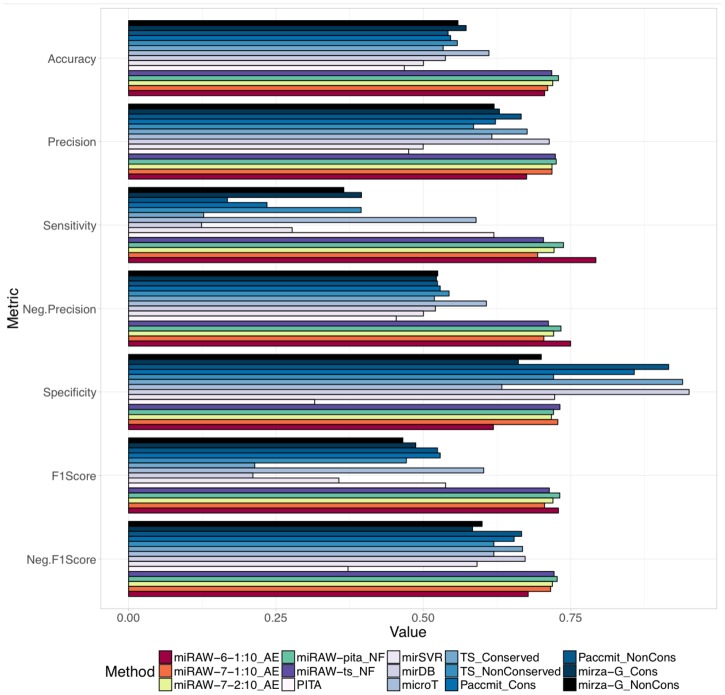
Comparison of miRAW with different CSSMs and eight other commonly used target prediction tools (TargetScan C & NC, Diana microT-CDS v4, PITA v6, miRanda, Paccmit, mirzaG and mirDB).Colouring for miRAW results are consistent with the color scheme in Fig 5; other prediction tools follow a light to dark blue color schema. Evaluation was determined in terms of accuracy, precision, sensitivity, negative precision, specificity and F1-score (an ideal predictor would obtain a score of 1 for each metric). All miRAW configurations outperformed other methods in terms of accuracy and F-scores, which are good representations of general measures of performance. mirDB and Target-Scan (highly conserved targets) obtained high specificity scores but a low negative precision as a consequence of their conservative approach, which classified almost all the miRNA:mRNA pairs as negative. After miRAW, microT was the method which presented better and more balanced results.